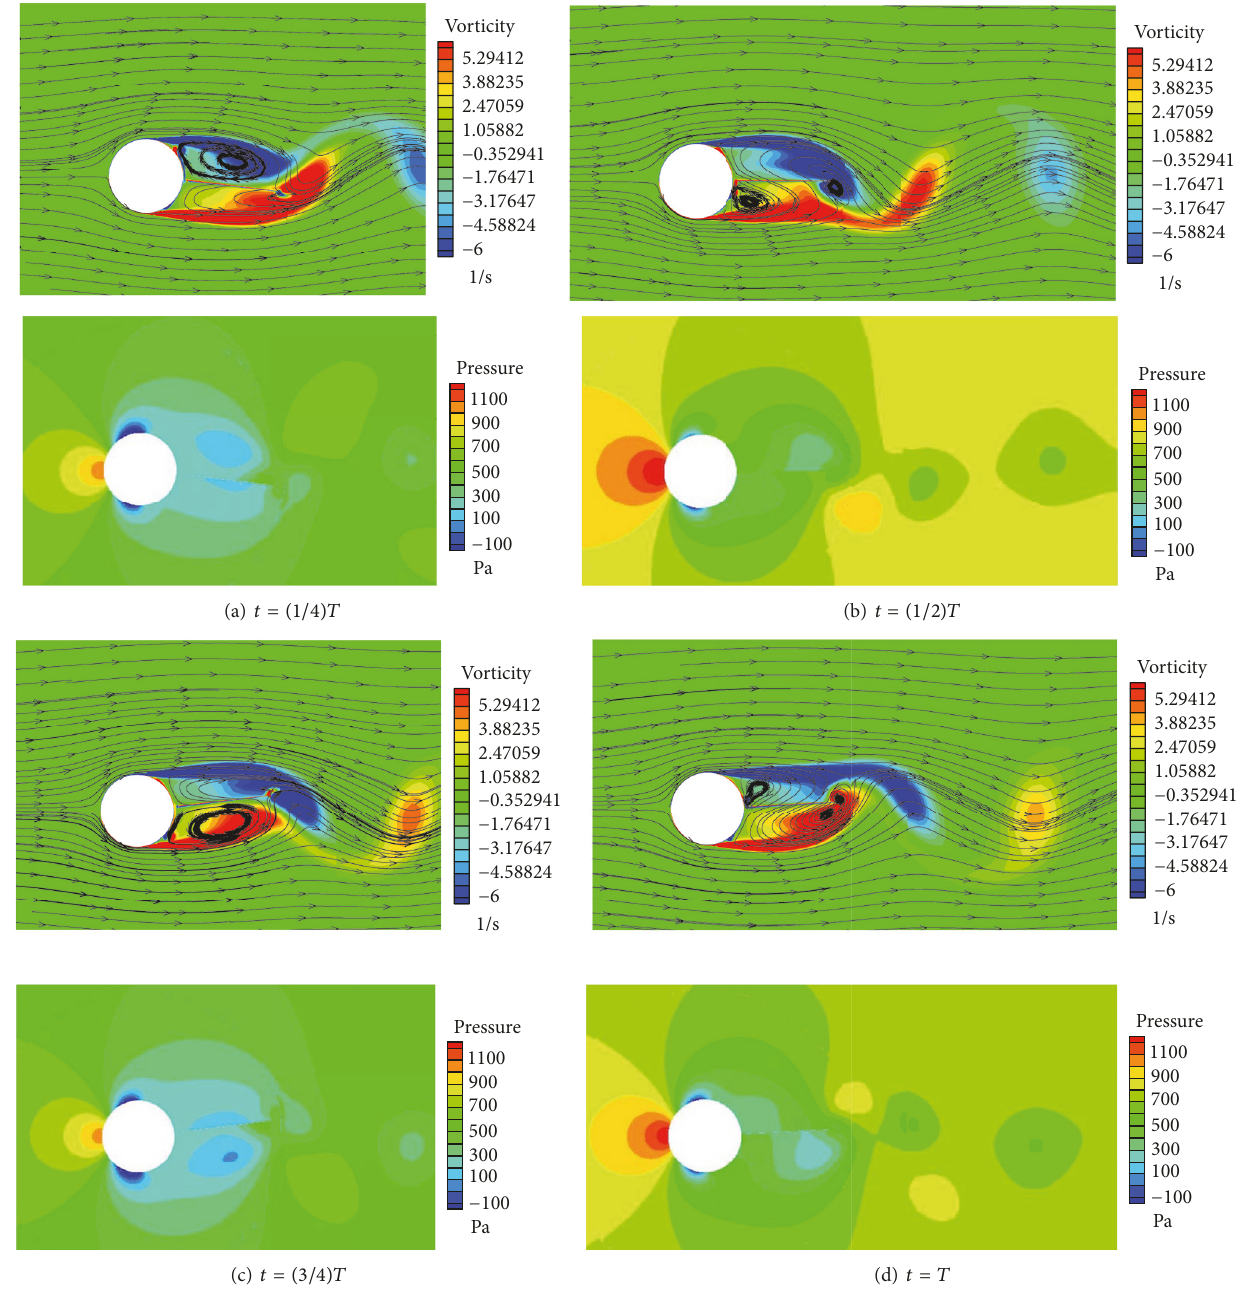
Figure 17: The different interval cycle contours of vorticity and